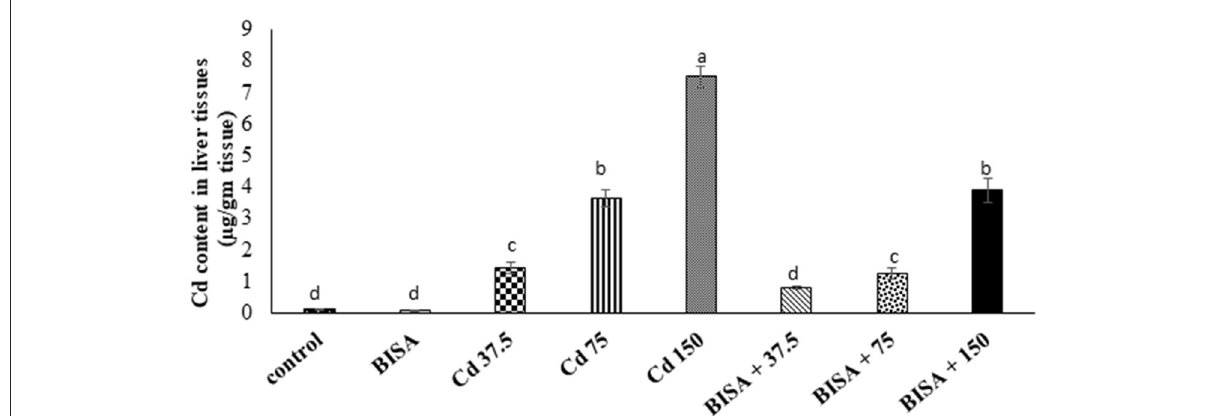
FIGURE1 Concentration of Cd in the hepatic tissue of ducks following treatment with oral α -bisabolol (50 mg/kg/day) and/or CdCl 2 at 37.5, 75, and 150 mg/kg diet, respectively) for 4 weeks. Data are shown as mean ± SEM ( n = 6 ducks). Bars carrying different letters are significantly different from one another ( p < 0.05). C, control; BISA, α -bisabolol.